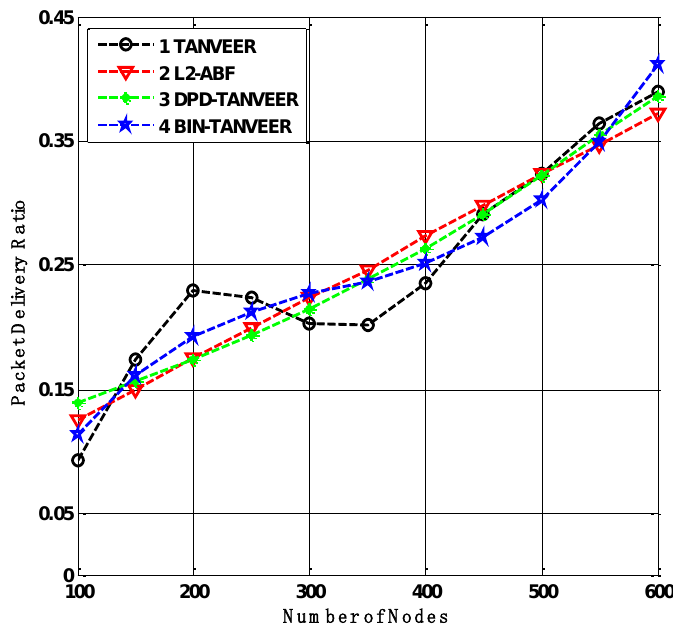
Figure 13. Packet delivery analysis of TANVEER vs. L2-ABF.